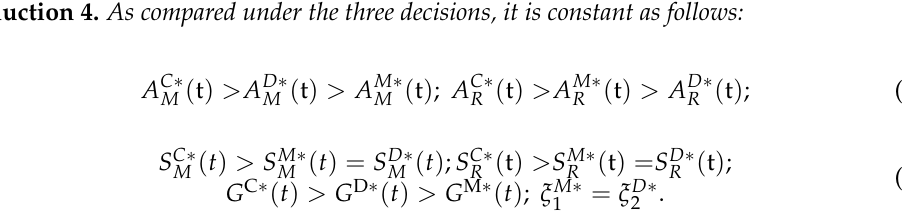
Figure 3. Im pact of Time Delay on the Brand Owner’s Profit. As the service delay time 2 d of the retailer increases, the brand owner benefits from the improvement of the retailer’s service level. According to Deductions 2 and 3, the brands’ share of the retailer service cost ratio 2 decreases at this moment, so the profit of the brand owner increases continuously. As can be seen in Figure 4, similar to the case of the brand owner, the increase in the delay time 1